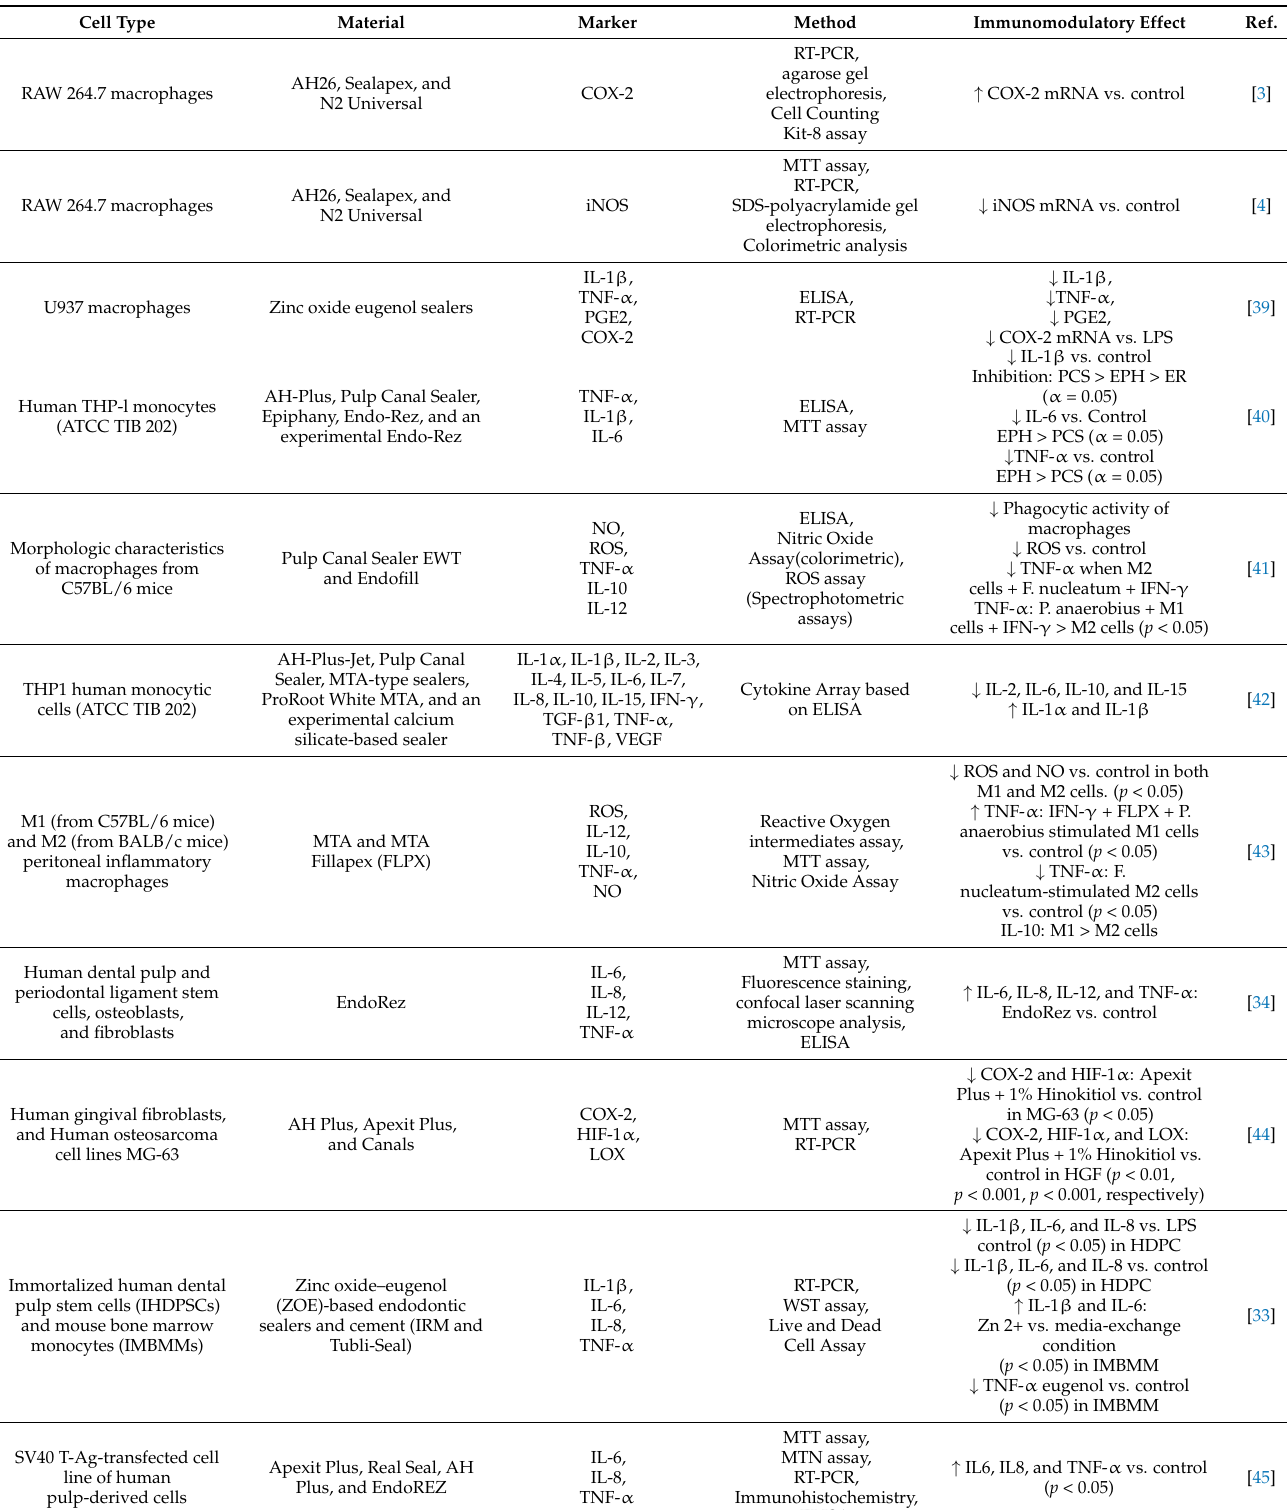
Table 1. Summary of immunomodulatory effect of endodontic sealers in vitro